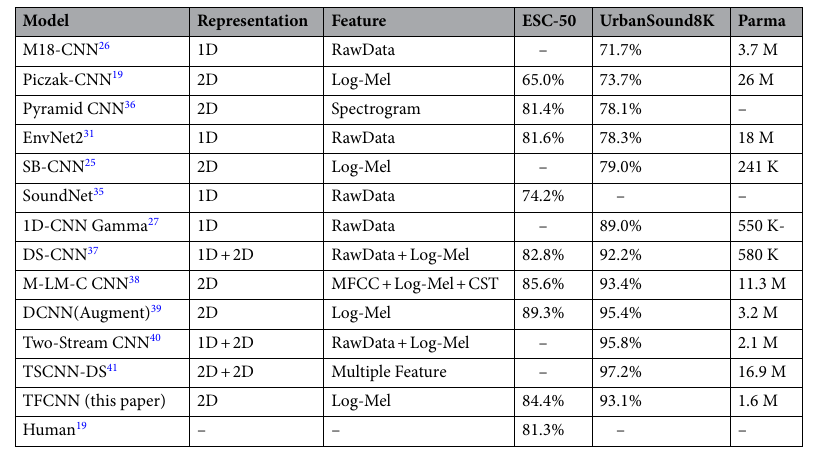
Table 5. Compare with other models on the Urbansound8K and ESC-50